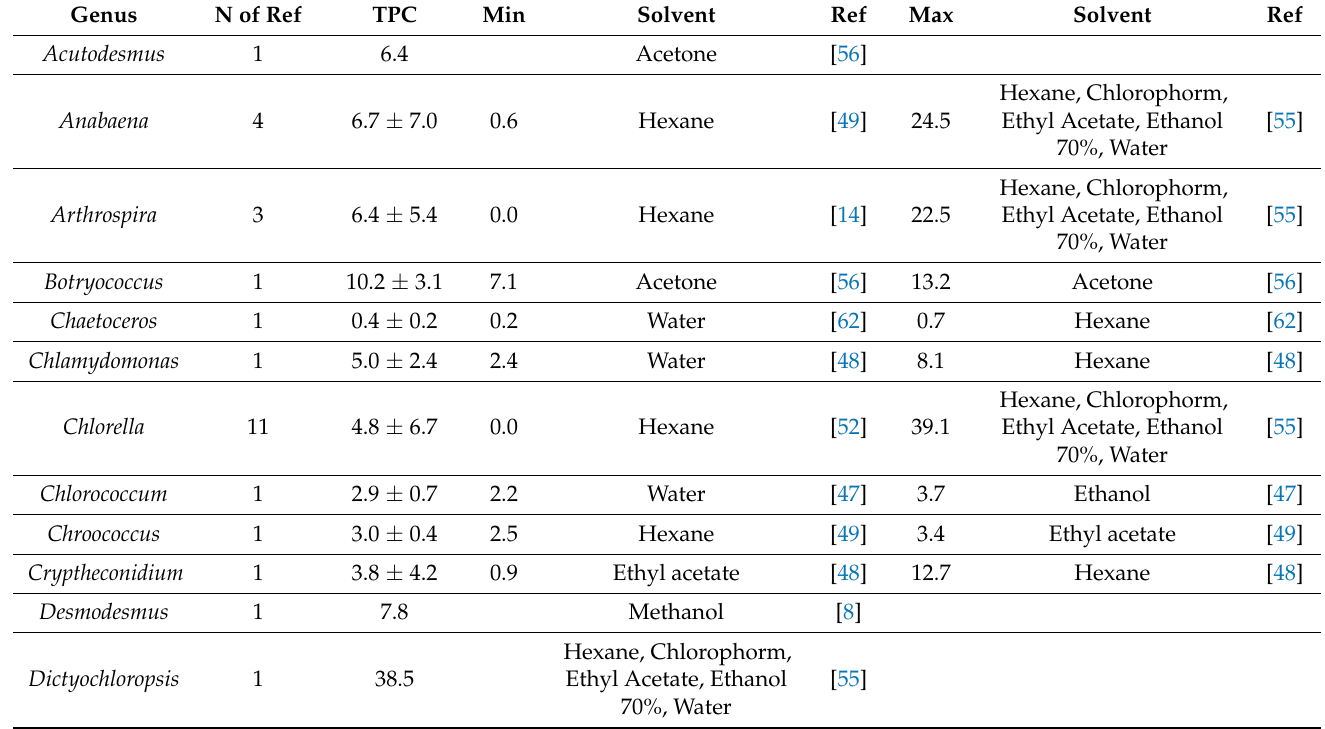
Table 5. Average, maximum and minimum values of TPC for various genera of microalgae and cyanobacteria. The number of references from which the average values were calculated is also